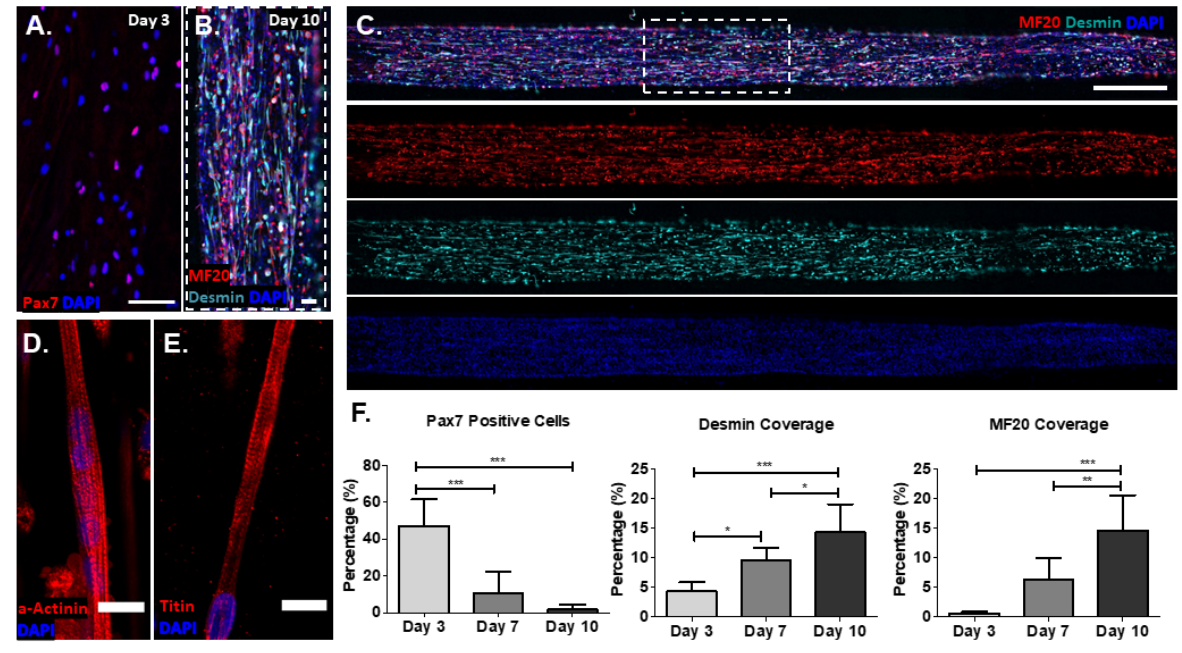
Figure 2. PAX7-sorted myogenic progenitors form engineered 3D skeletal muscle grafts. ( A ) Day 3 expression of Pax7 in sorted myogenic progenitors grown on fibrin microfiber bundles (scale bar: 100 µm). ( B ) By day 10, sorted myogenic progenitors fuse to form desmin and MHC positive myotubes (scale bar: 100 µm). ( C ) Desmin and MHC expression are consistent along the entire length of the fibers (scale bar: 1 mm). ( D , E ) Striated myotubes expressing a-actinin ( D ) and titin ( E ) (scale bars: 20 µm). ( F ) Quantification of pax7 desmin, and MHC (MF20) expression over time from myogenic